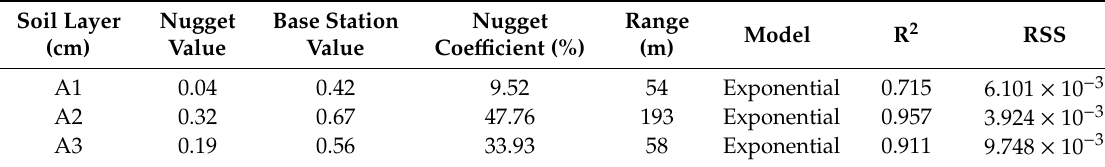
Table 2. Geostatistical parameters of soil iron at di ff erent depths.